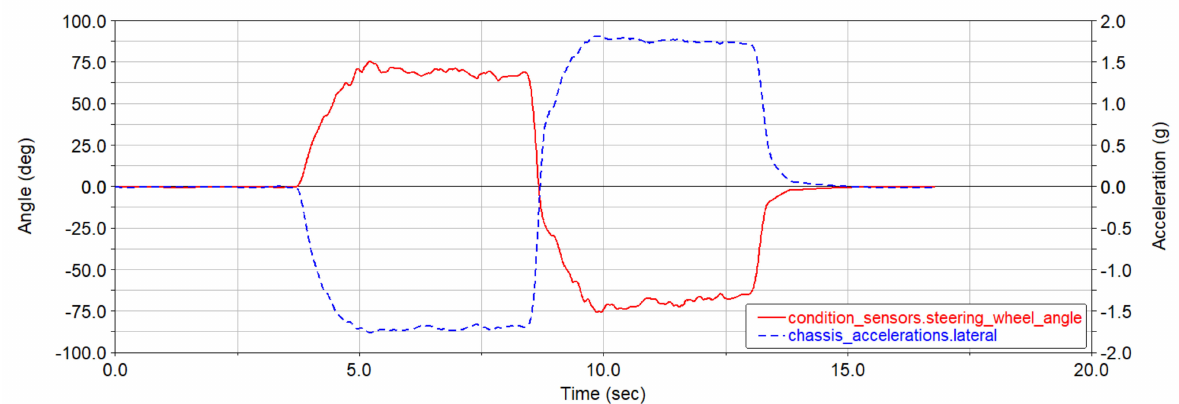
Figure 17. Skidpad Event—Dynamic response, baseline set-up.